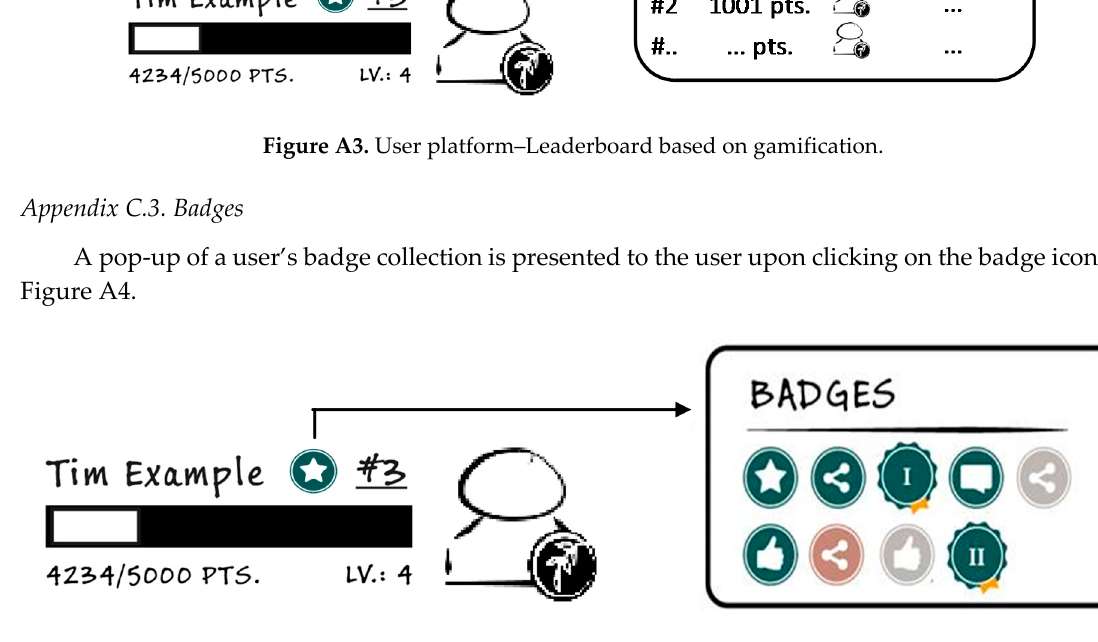
Figure A4. User platform–Users badge collection based on